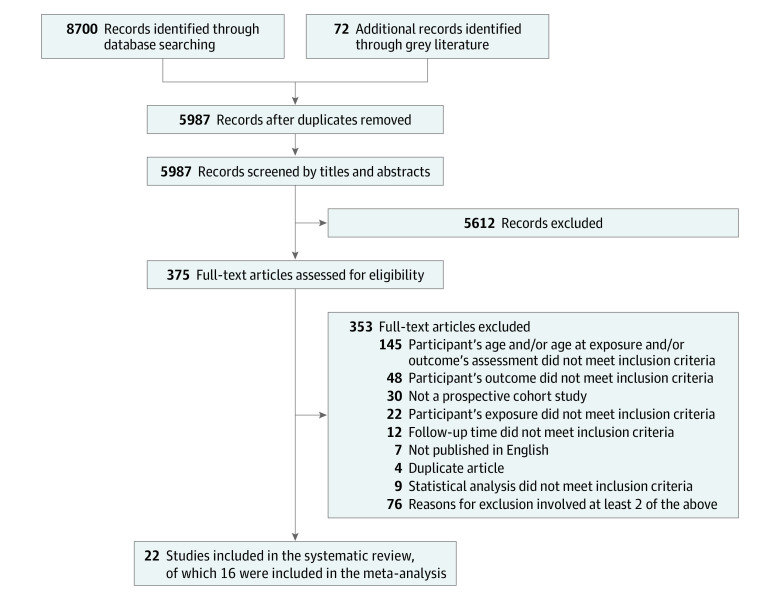
PRISMA Flow Diagram of Included Studies